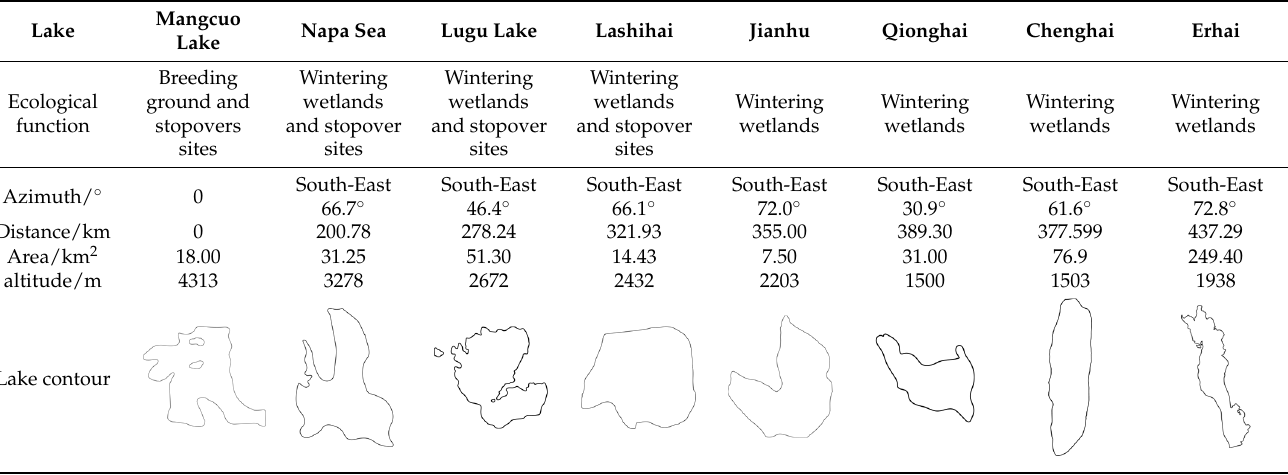
In the migratory pathway of migratory birds in the Hengduan Mountain system, a series of wetlands are given different ecological functions, and with the elevation, the ecological functions of the lakes in the Hengduan Plateau supporting the life history of migratory waterbirds are gradually transformed about three levels; the first level of Qionghai, Chenghai, Erhai, and Jianhu at an elevation of 1500–2200 m is the most important ecological function of providing important wintering grounds for wintering waterbirds (especially geese and ducks) [20–23]. The second layer of Lashihai, Lugu Lake, and Napa Sea at 2400–3300 m above sea level are not only wintering wetlands for migratory birds but also important stopover sites [24–26]. The third layer, Mangcuo Lake, at an altitude of 4000 m above sea level, provides a breeding ground for some migratory waterbirds in summer and a stopover for migratory waterbirds in spring and autumn. In highland regions, a particular wetland would not be able to supply the dietary demands of all waterbirds due to food resource limitations. Benefiting from the connectivity of migration channels, some birds with high food demands can move around between adjacent